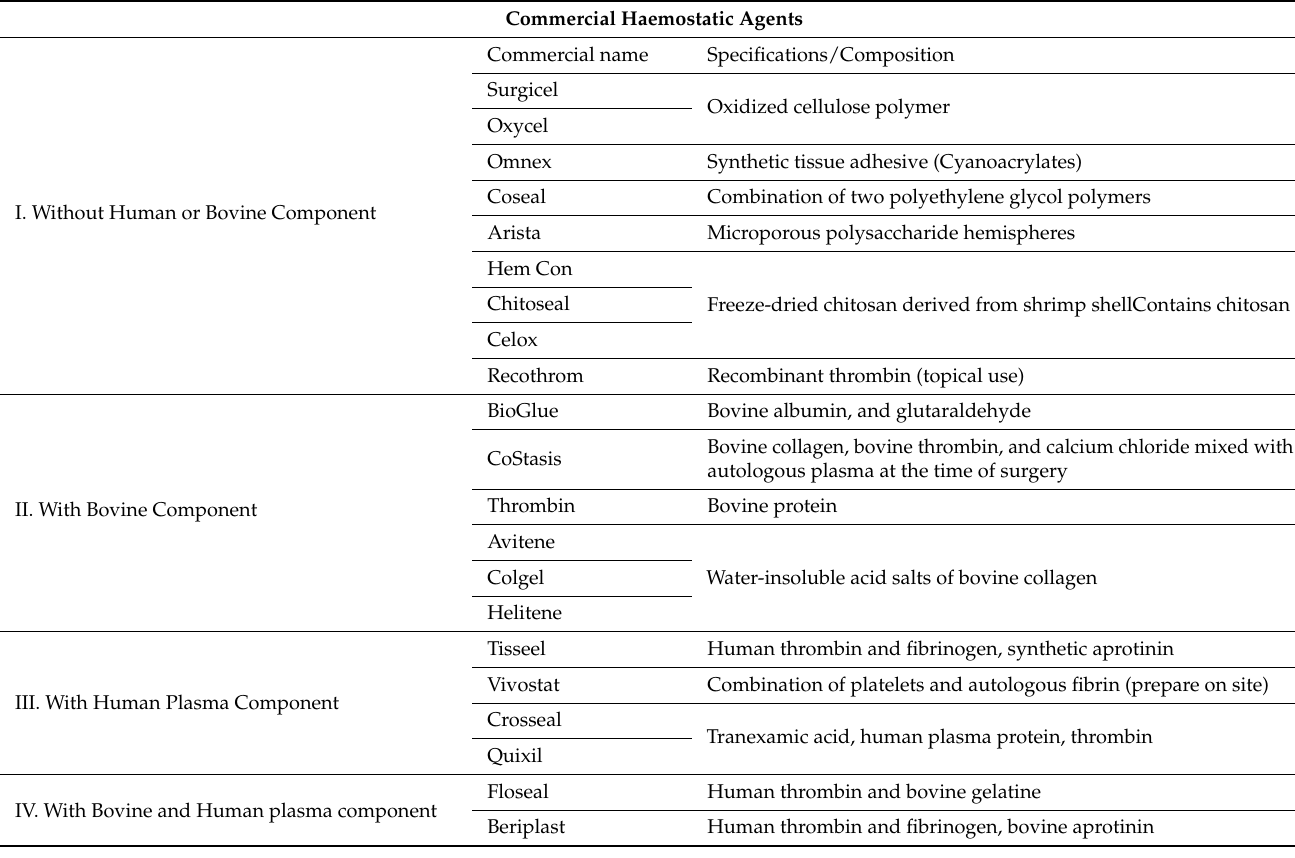
Table 1. Classification of commercial haemostatic agents based on component